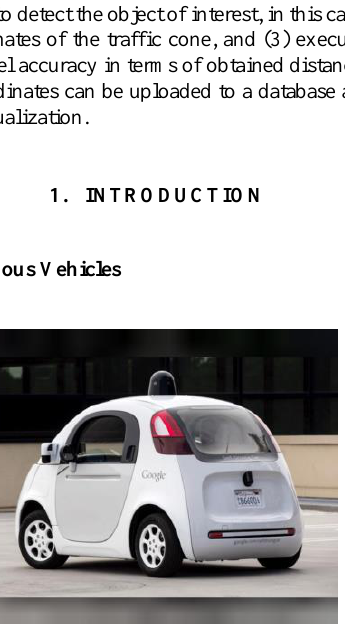
Figure 1. Google’s Self Driving Car (taken from reuters.com)